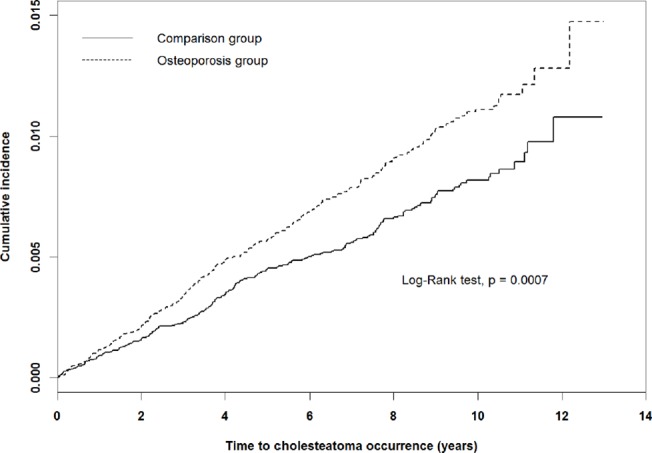
Cummulative incidence of acquired cholesteatoma for patients with (dashed line) or without (solid line) osteoporosis.